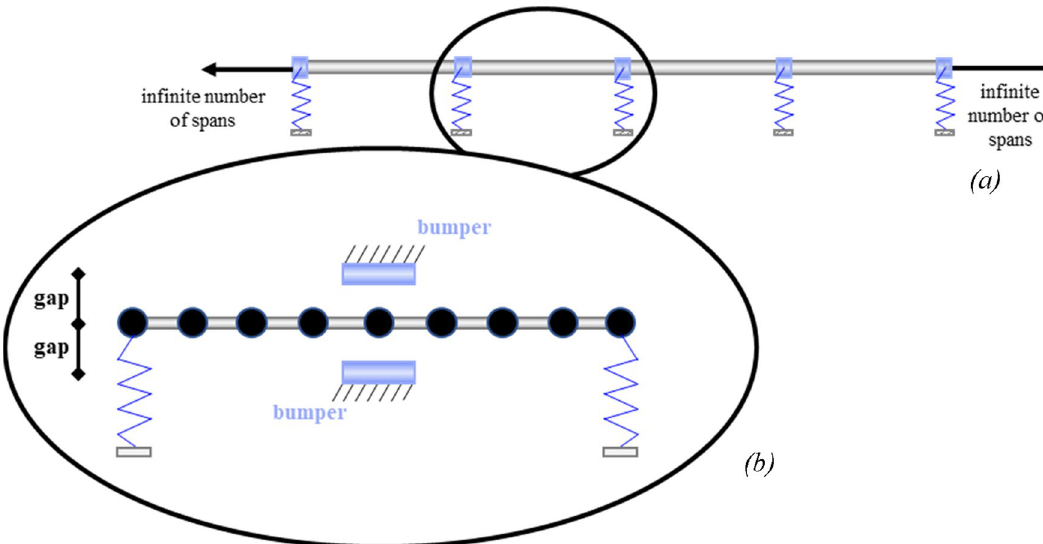
Figure 1. ( a ) Periodic damped pipeline on flexible supports and ( b ) single span (SS) endowed with a vibro- impact system (VIS) for impact-based energy